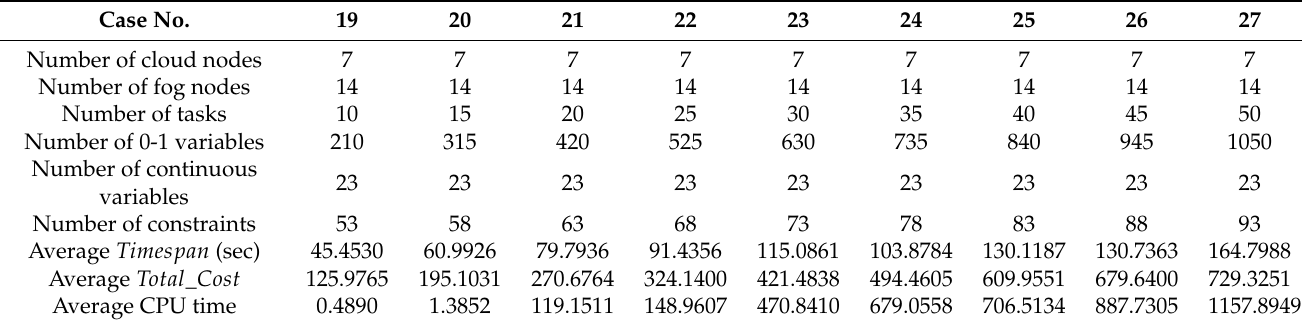
Table 5. Experimental results of the proposed method for 7 cloud nodes and 14 fog nodes (dataset 3). Case